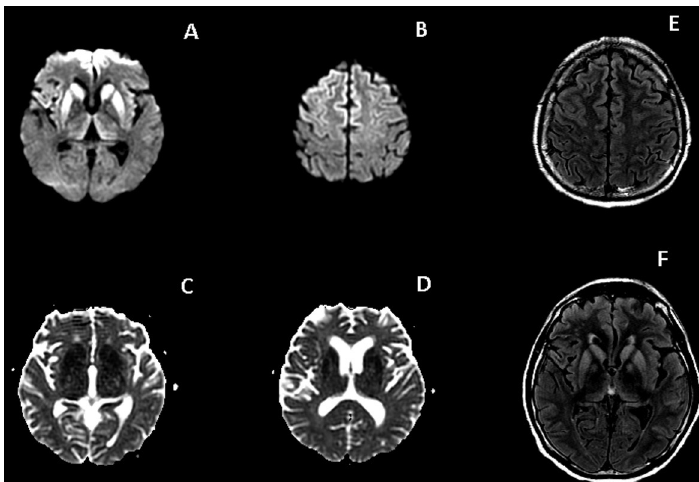
Figure 1. Case 1. Axial T2-weighted (A) and FLAIR (B) im- ages: hyperintensity in basal ganglia, with less evident hyperintensity in cortex. Axial post-contrast T1-weighted image (C) shows no enhancement. Axial DWI (D, E): hyper- intensity more evident than on T2/FLAIR images, involving the caudate nuclei bilaterally, putamen, medial portion of the thalami and both frontal and insular cortices. DWI-hy- perintensity in basal ganglia and thalami have correspond- ing restricted diffusion on the ADC map (F).